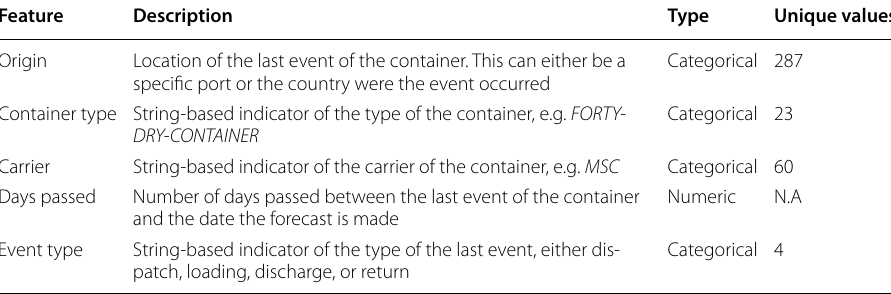
Table 1 Features of the destination prediction model. Source : Own elaboration